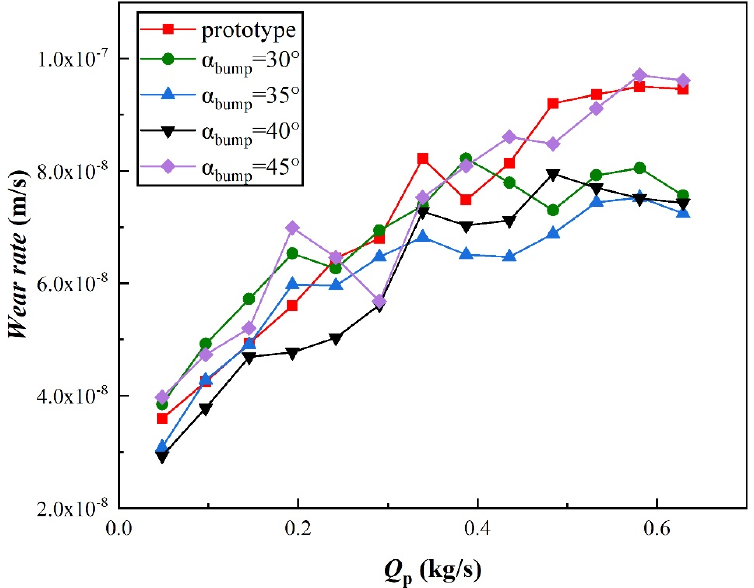
Figure 12. Schematic diagram of the wear rate of five convex bends for different particle mass flow rates. flow